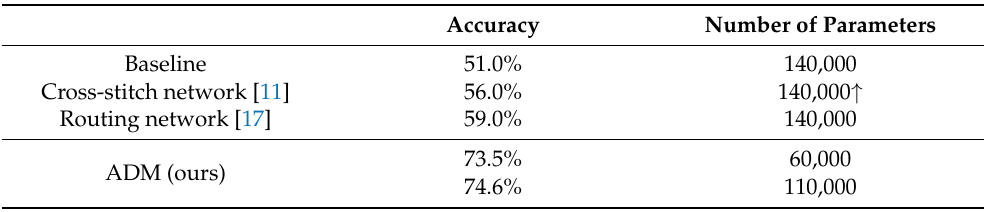
Table 4. Average classification results with the numbers of parameters of the compared methods for Mini-ImageNet (10 tasks). The accuracies of the other methods were borrowed from [17].